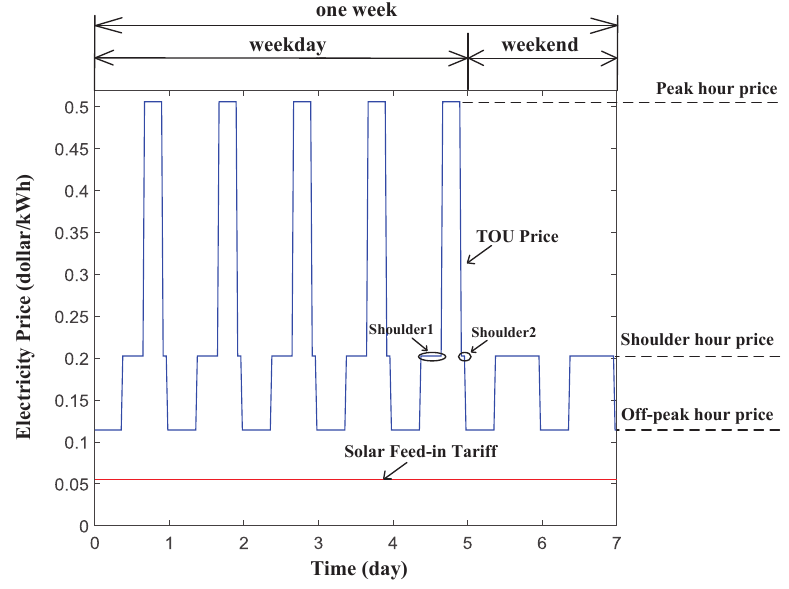
Figure 5. Profile of Australian time-of-use electricity